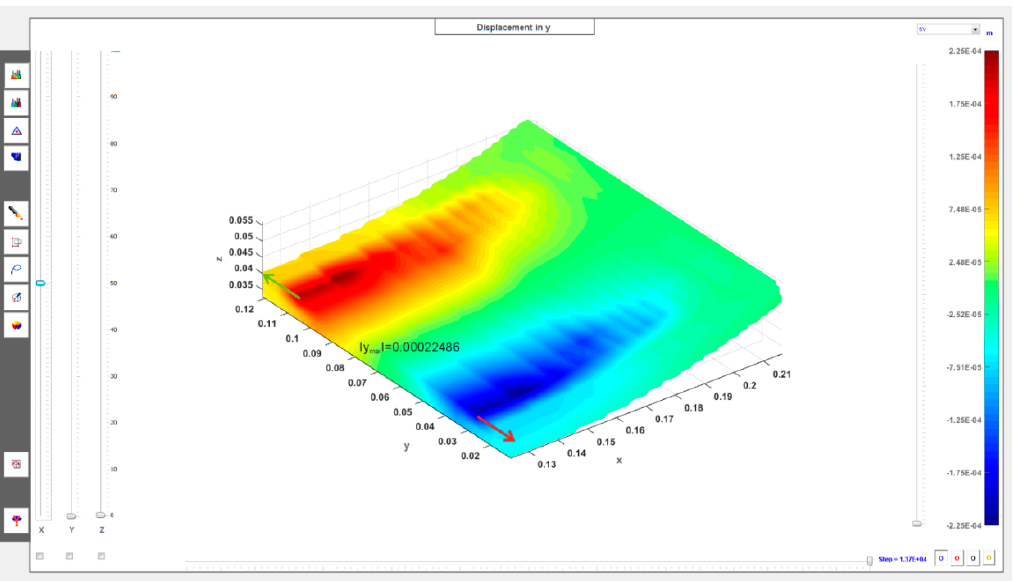
Figure 10. Displacements (in meters, middle section) in sand layer in parallel y direction to roller axis: h = 0 mm, p opt = 2.4 bar ( N = 1200 N).